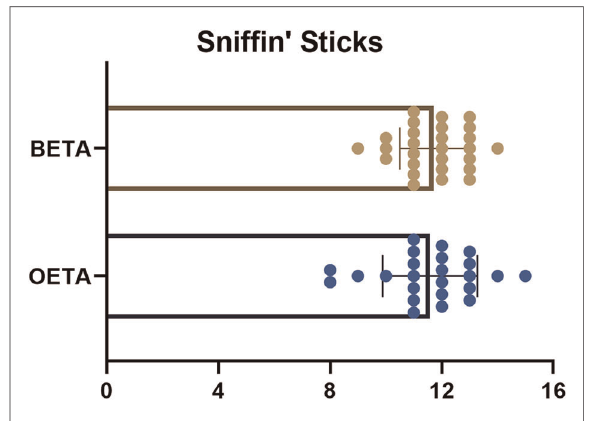
FIGURE 4 The scores of Snif fi n ’ Sticks in OETA and BETA. binostril endoscopic transsphenoidal approach, BETA; one-and-a-half nostril endoscopic transsphenoidal approach,